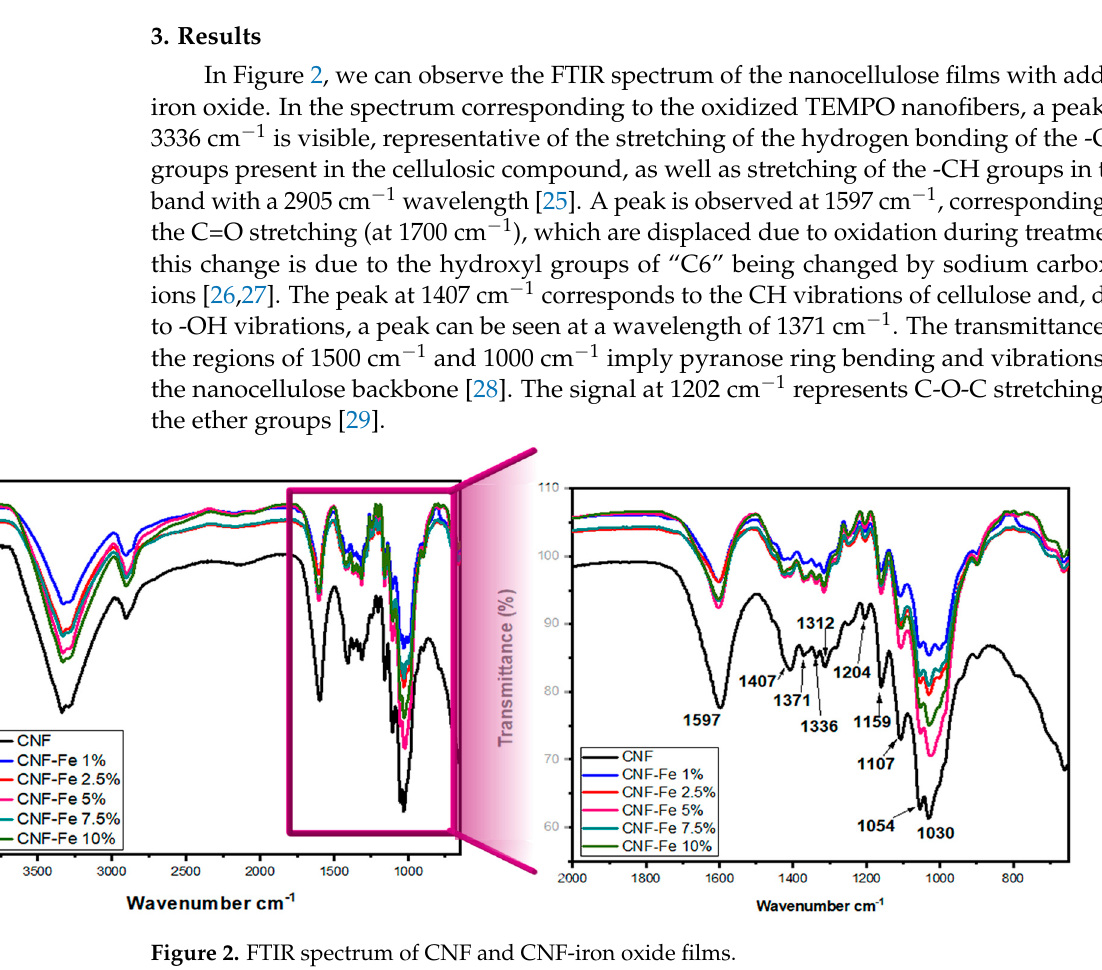
Figure 1. ( A ) Nanocellulose solutions at different concentrations. ( B ) CNF ‐ Fe films with ( a ) 1% w / w Fe, ( b ) 2.5% w / w Fe, ( c ) 5% w / w Fe, ( d ) 7.5% w / w Fe, (e d ) 10% w / w Fe.